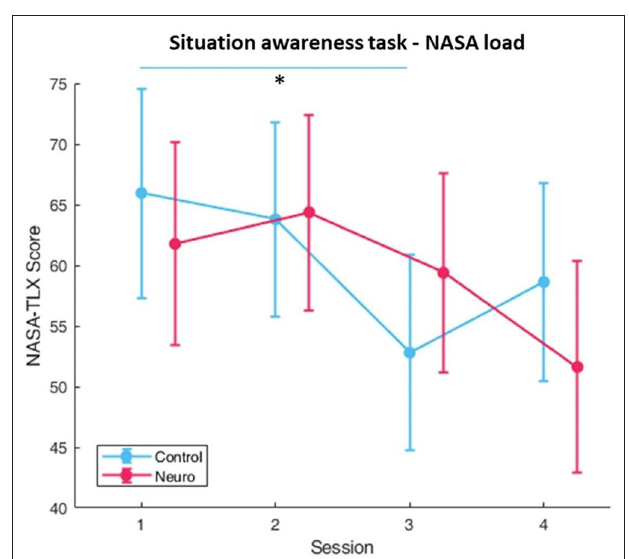
FIGURE 7 | Oxygenated hemoglobin changes over time corrected with level covariate. Significant condition and session interactions were found (whiskers are SEM, * p < 0.05).